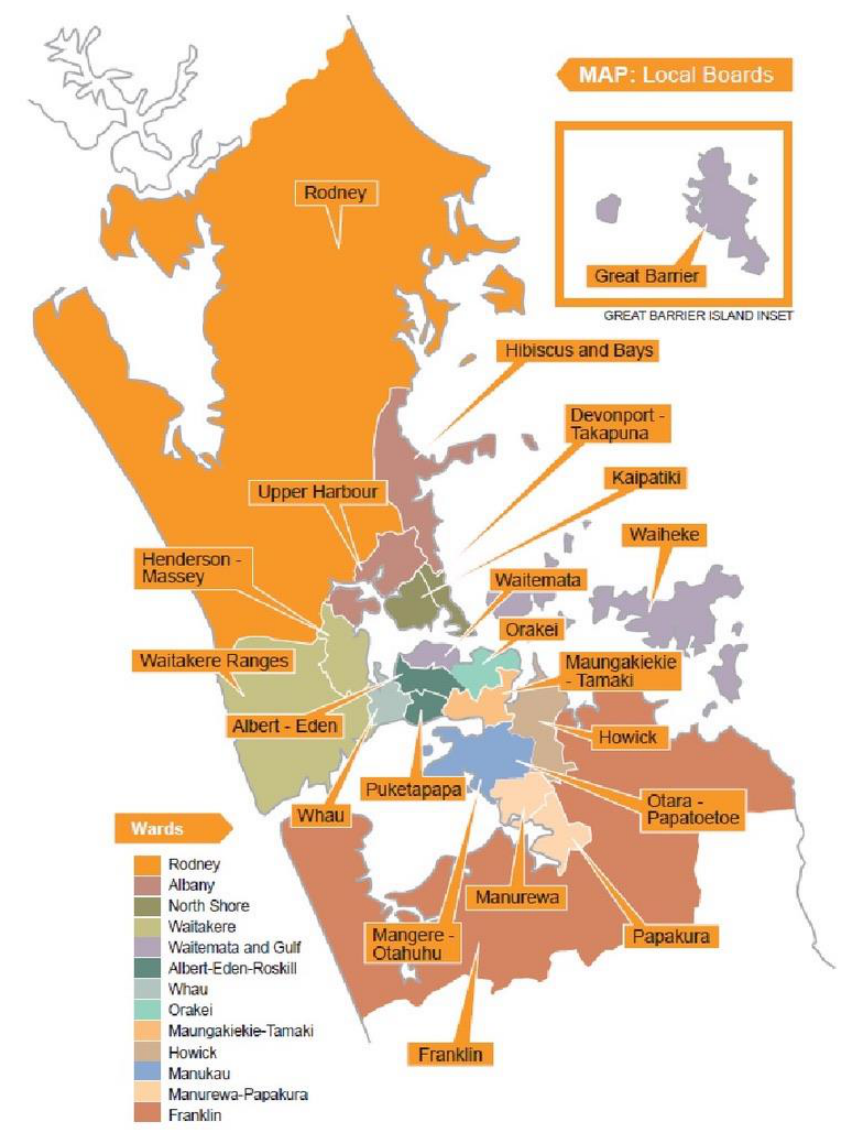
Figure 1. Map showing the locations of Tāmaki Makaurau’s 21 local boards. Map source [72]. Face-to-face interviews were conducted in late February 2020 in J.L.R. and J.C.’s homes, and a telephone interview with the third community leader (R.F.) in early March 2020. The three audio- recorded interviews ranged in length from 33:58 to 48:22 minutes and were transcribed verbatim.